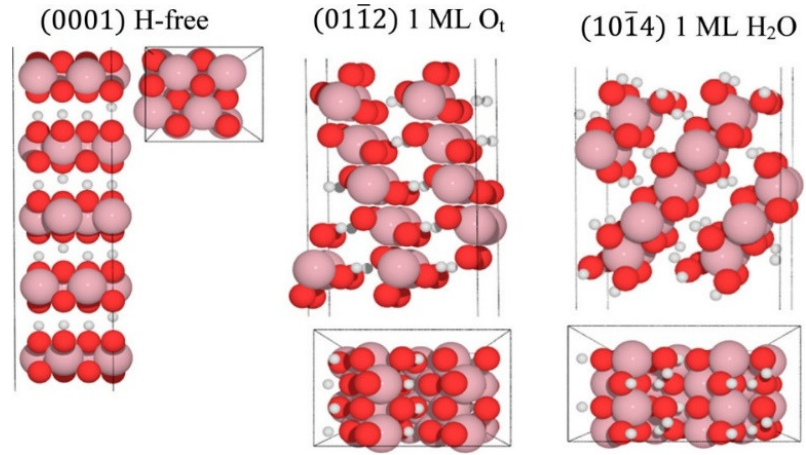
Figure 23. Side- and top-views of the optimized geometries for the lowest-energy surfaces of β- CoOOH represented as 5-layer symmetric slabs and used to determine the surface energies. The small white spheres represent H, the red spheres represent O, and the large pink spheres represent Co atoms. (Reprinted from ref. [68] with permission from Journal of American Chemical Society. Copyright © 2013, American Chemical Society).